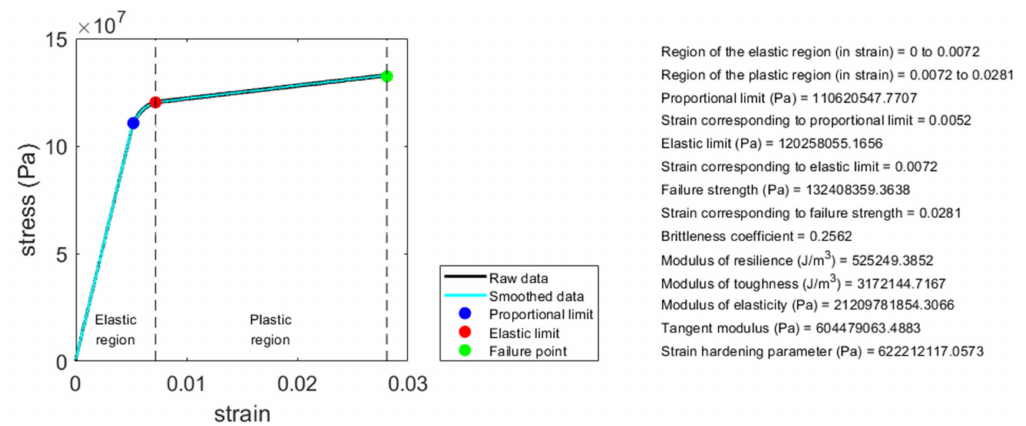
Figure 5. Illustration of an example of the analysis result using the MATLAB computer programming code provided along with this article. By analyzing the bilinear stress–strain curve of a material using this computer code, the associated mechanical properties can be